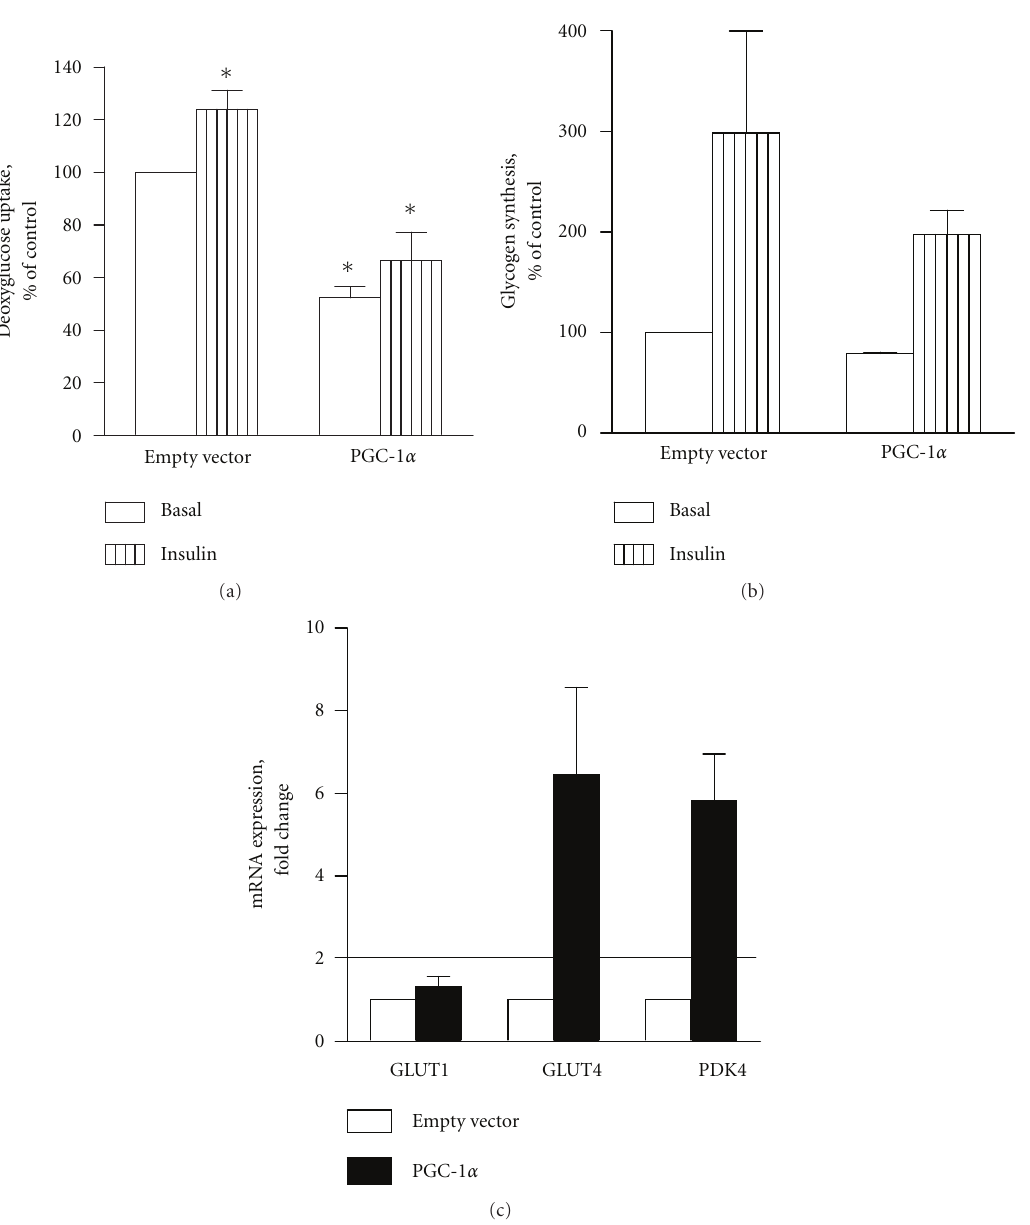
Figure 6: Deoxyglucose transport (a), glycogen synthesis (b) and mRNA expression (c) of GLUT1, GLUT4 and PDK4 in human myotubes infected with either empty vector or PGC-1 α . (a): Cultured myotubes infected with either empty vector or PGC-1 α were incubated with 1mL/well of serum-free DMEM ± cytochalasin B 10 μ M for 60min, followed by a 15 min exposure to 2-deoxy-D-[ 3 H]glucose (1 μ Ci/mL) with or without cytochalasin B, and with or without insulin, as described in Section 2. Values are normalized to the levels of uptake in control cells infected with empty vector and presented as means ± SEM of 4 experiments, representing 3 di ff erent donors, with 3 replicates each. ∗ Statistically significant compared to basal uptake in control cells infected with empty vector ( P < 0 . 05 ) (b): Myotubes infected with either empty vector or PGC-1 α were incubated for 2h in serum-free DMEM ( ± insulin), and then exposed to D-[ 14 C(U)]glucose ± insulin. After 60min, the cells were washed three times with ice-cold PBS and lysed with 1M NaOH. Synthesised glycogen was measured as described in Section 2. Values are presented as means ± SEM of 2 experiments, each representing one donor, with 3 replicates each. (c): mRNA expression of GLUT1, GLUT4 and PDK4. mRNA was isolated from cultured myotubes infected with either empty control vector or PGC-1 α eight days after the onset of di ff erentiation. Expression was assessed by RT-PCR, and values are presented as means ± SEM of 3 experiments, each representing one donor, with 3 replicates each, normalized to the levels of housekeeping gene 36B4. A fold change ≥ 2 or ≤ 0.5 was considered an increase or decrease in expression level,